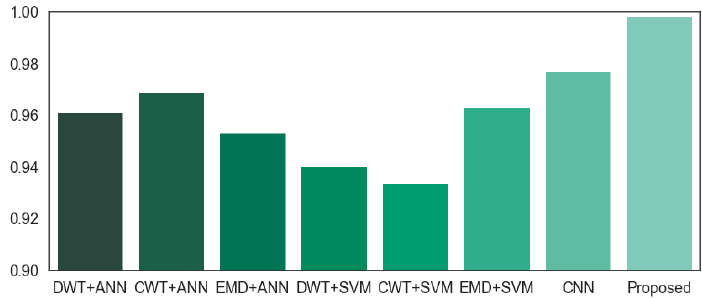
Figure 18. Tested accuracy rate performance comparison.